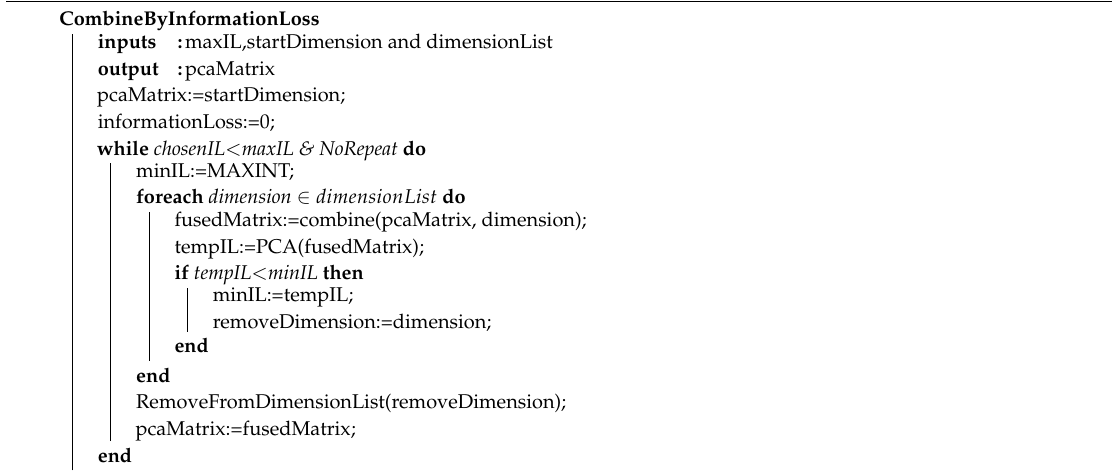
Algorithm 1: Recommendation based on information loss. The information Loss is used to remove dimensions from the matrix.